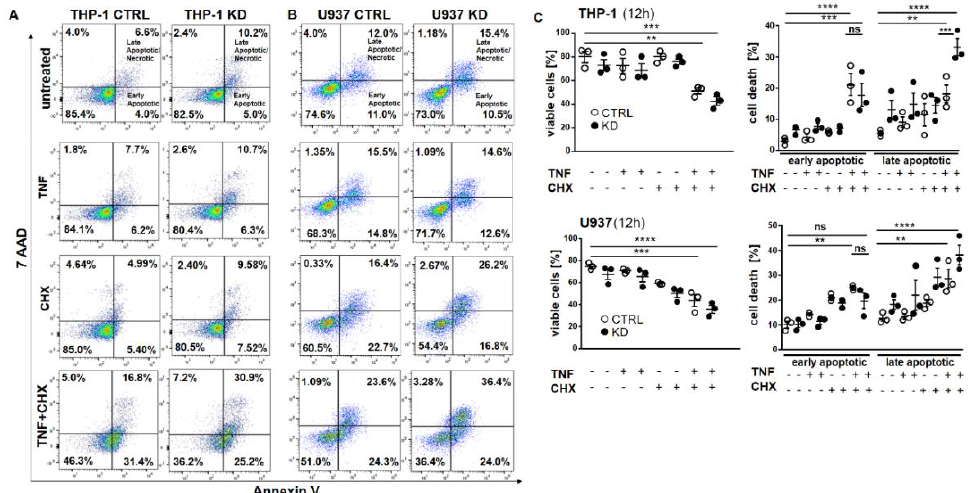
Figure 3. YB-1 was protective against cell death in vitro. (A,B) Representative flow cytometry dot plot analyses of THP-1 ( A ) and U937 cells ( B ). Cells were treated with or without TNF (20 ng/mL) and cycloheximide (10 ng/mL) alone or together overnight. Cells were harvested and stained for annexin V and 7AAD. ( C ) Graphs representing flow cytometry analysis of live and dead cells in THP-1 and U937 cells. Statistical significance was calculated by two-way ANOVA with Bonferroni post hoc test, n = 3. Data represent the mean ± SEM. ** p < 0.01, *** p ≤ 0.001, **** p ≤ 0.0001.